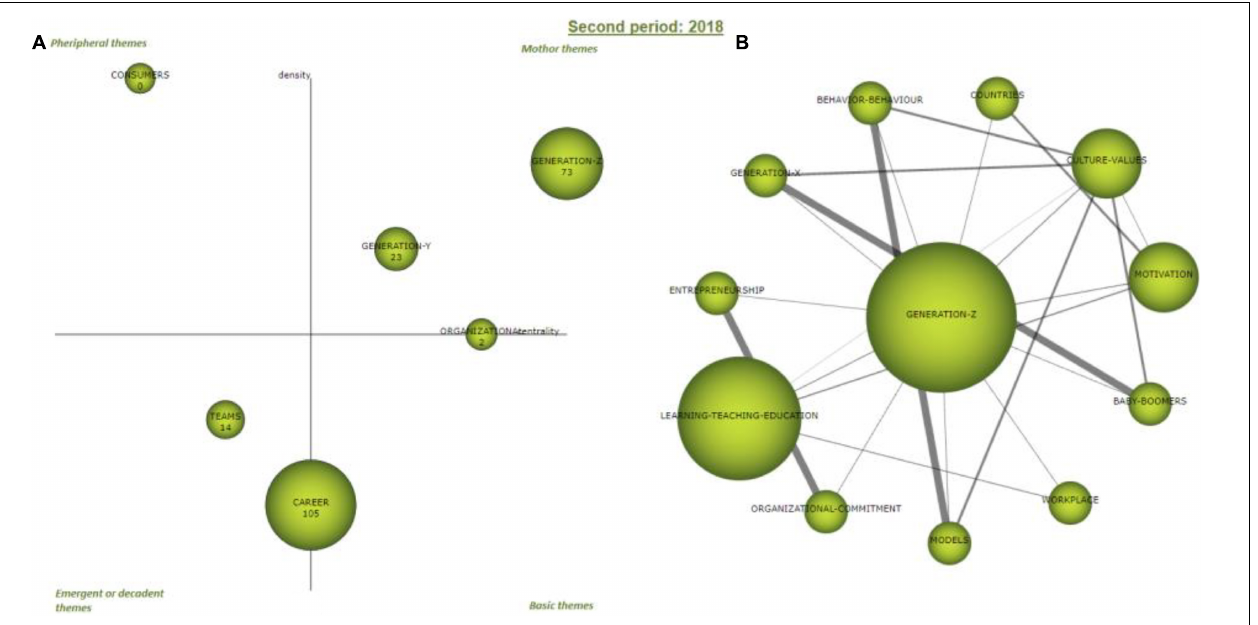
FIGURE 6 | Period 2018 strategic diagram (A) and motor cluster’s network (B) . Source: Elaborated with SciMAT.